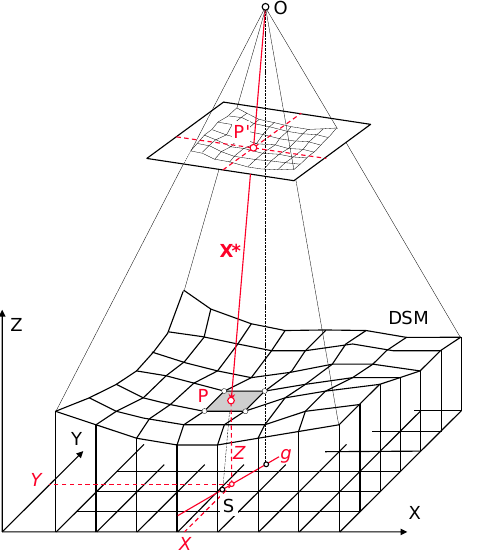
the DSM each measured image point defines a direction vector pointing onto the surface. In case of 2½ D object models, e.g.